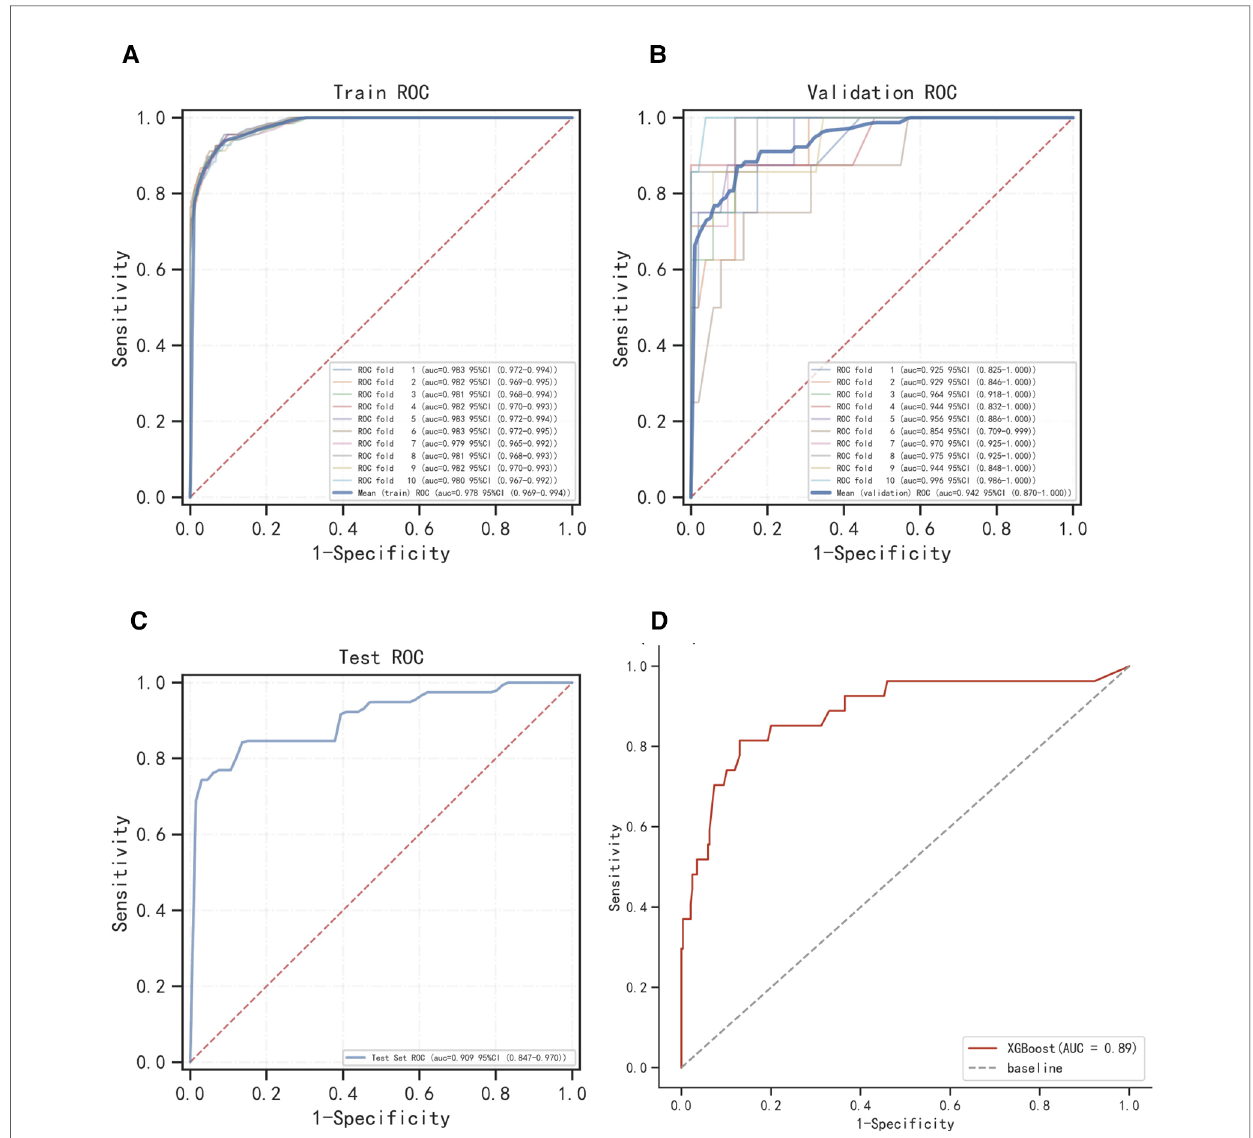
FIGURE 3 Internal validation of XGBoost model. ( A ) ROC curve of XGBoost model for the training set. ( B ) ROC curve of XGBoost model for the validation set. ( C ) ROC curve of XGBoost model for the test set. ( D ) External validation of XGBoost